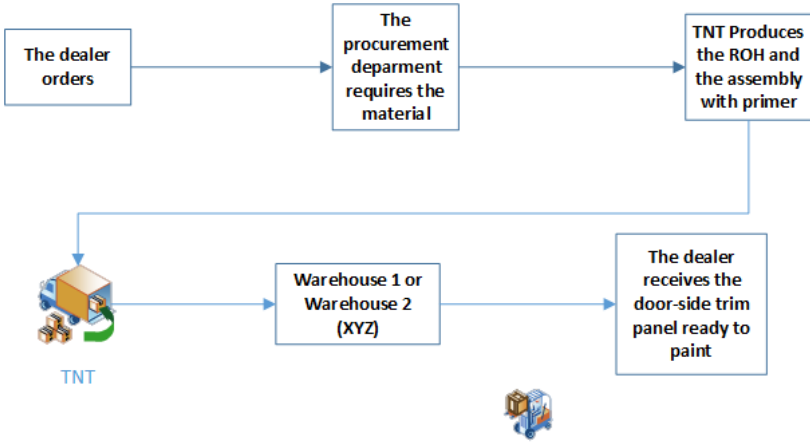
Figure 18. Second proposal for improvement.